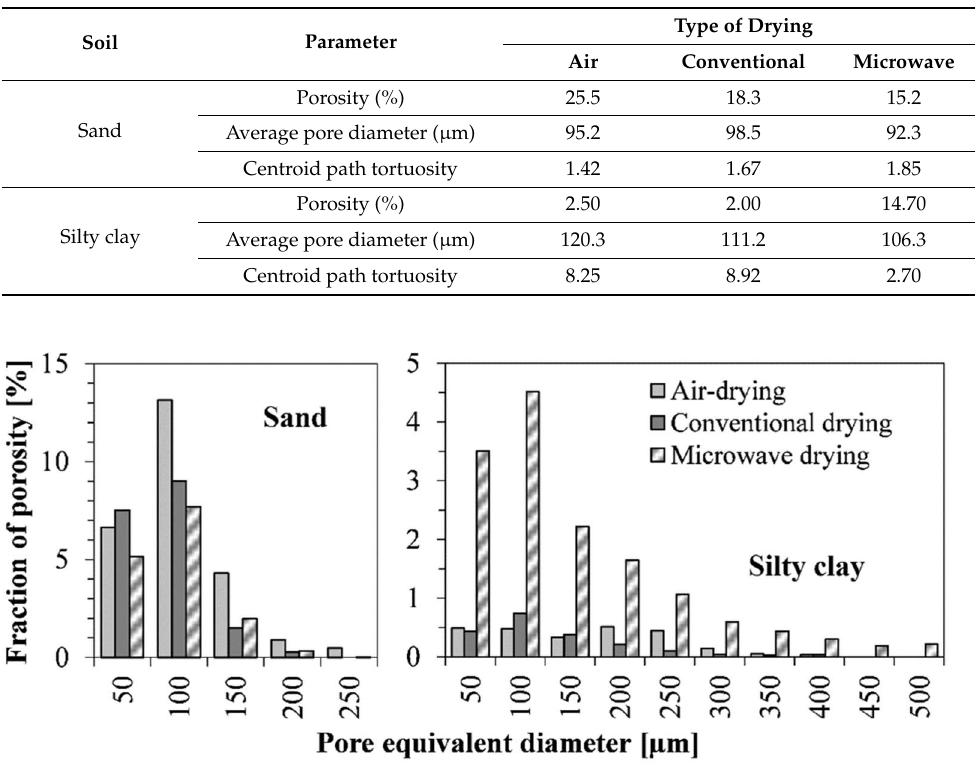
Table 4. Quantitative characteristics of the microstructure of soils dried by various methods.